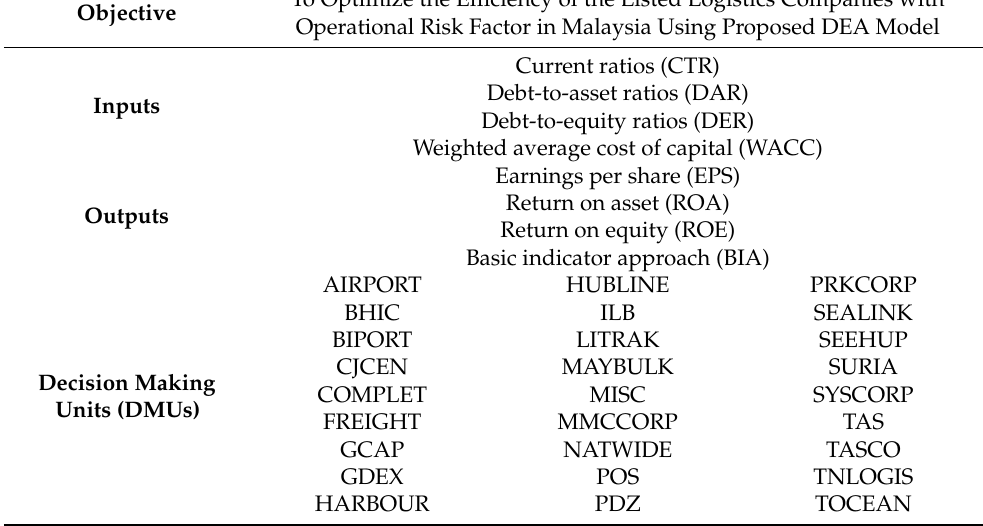
Table 1. Proposed research framework.